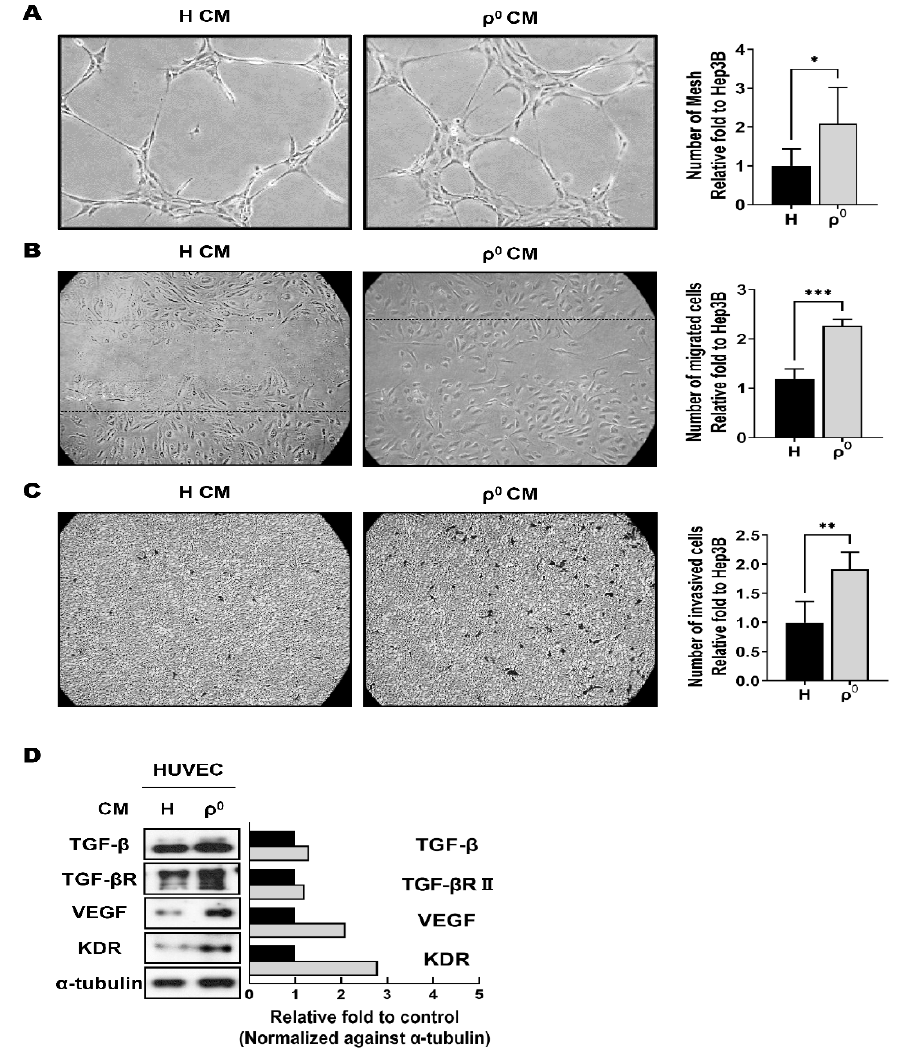
Figure 3 . Hep3B/ ρ 0 conditioned medium (CM) promotes angiogenic effects. Angiogenic effects of CM were evaluated with tube formation ( A ), wound healing assay ( B ), and invasion assay ( C ) using human umbilical vein endothelial cells (HUVECs). ( A ) HUVECs were treated with CM for 24 h and the number of mesh was calculated (right graph) (* p < 0.05). ( B ) Wound healing assay for HUVEC migration using Hep3B/ ρ 0 CM (*** p < 0.0005). ( C ) Invasion assay for HUVEC invasion using Hep3B/ ρ 0 CM. Representative image of treated CM for 24 h and graph of the migrated cell count at 24 h. (** p < 0.005). ( D ) Western blot analysis of angiogenesis markers after treatment with CM in HUVECs. Graph showing respective molecule levels normalized to the loading control. Black box: Hep3B. Grey box: Hep3B/ ρ 0 .